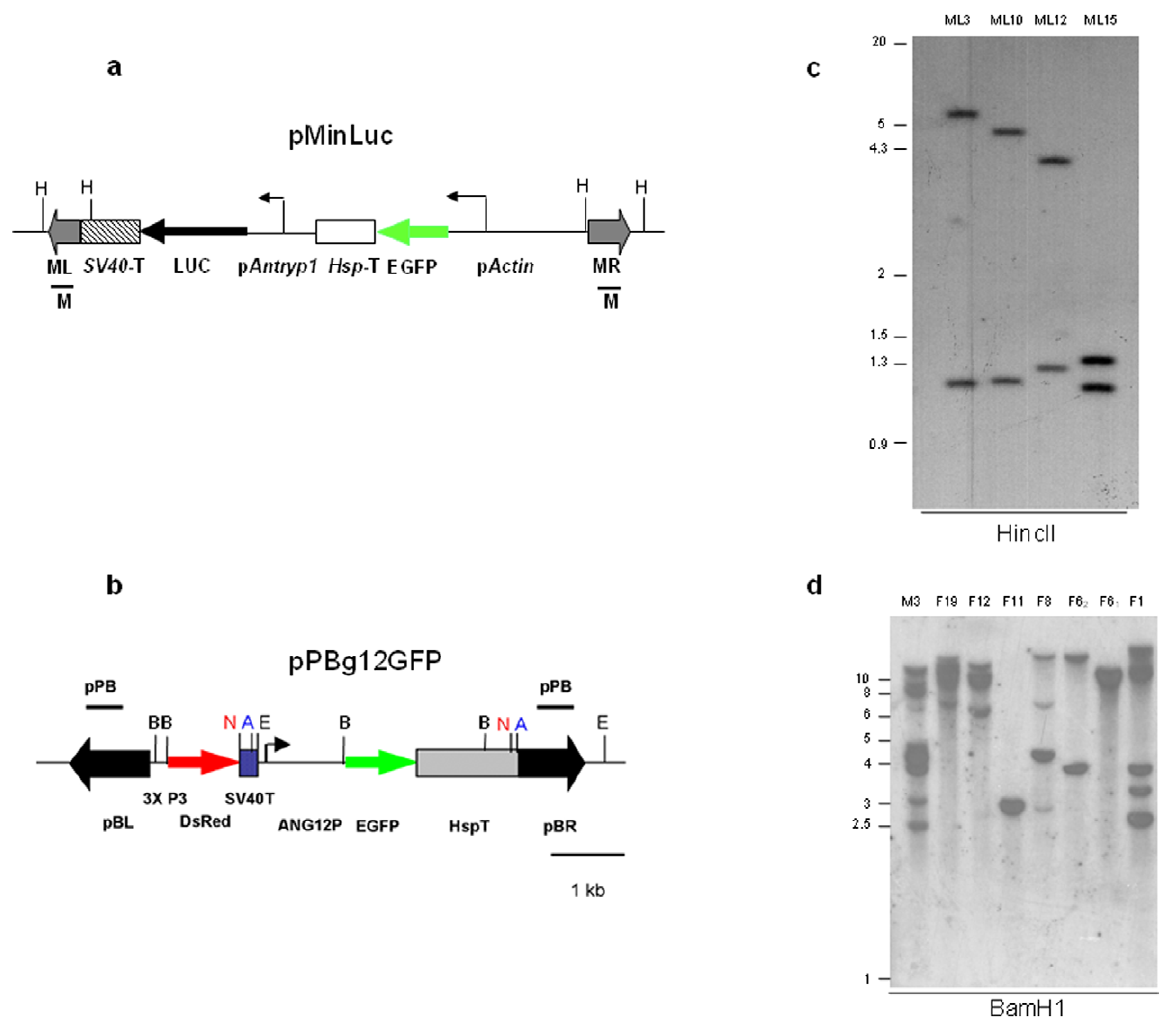
Figure 1. The piggyBac and minos transposable elements integrate into the genome of A.stephensi . Maps of transformation vectors pMinLuc ( a ) and pPBg12GFP ( b ). p Actin , D. melanogaster Actin 5C promoter; Hsp T, D. melanogaster Hsp 70 terminator sequence; p Antryp1 , 1.1 kb of the upstream sequence of the Antryp1 gene; LUC , luciferase gene; SV40T, SV40 polyadenylation signal; 3xP3 , artificial neuronal-specific promoter; dsRed, red fluorescent protein; ANG12P, 1.1 kb of putative G12 promoter region pBL, piggyBac left arm; pBR, piggyBac right arm; ML, minos left arm; MR, minos right arm; H, Hinc II; E, Eco RI; B, Bam HI, N, Not I, A, Asc I. Black bars represent the probes (pPB and M) used in the Southern Blot analyses. c : Southern Blot analysis of A. stephensi lines AsML3, AsML10, AsML12 and AsML15 digested with Hinc II and hybridised with probe M (Figure 1a). Each individual transposon integration is expected to yield two hybridising bands. Minos -mediated lines were characterised by single transposon insertions d : Southern blot of A.stephensi lines transformed with pPBg12GFP. Genomic DNA from 8 different transgenic lines, resulting from 7 different founder families, was digested with Bam HI and hybridised with probe pPB, expected to give two hybridising bands per transposon